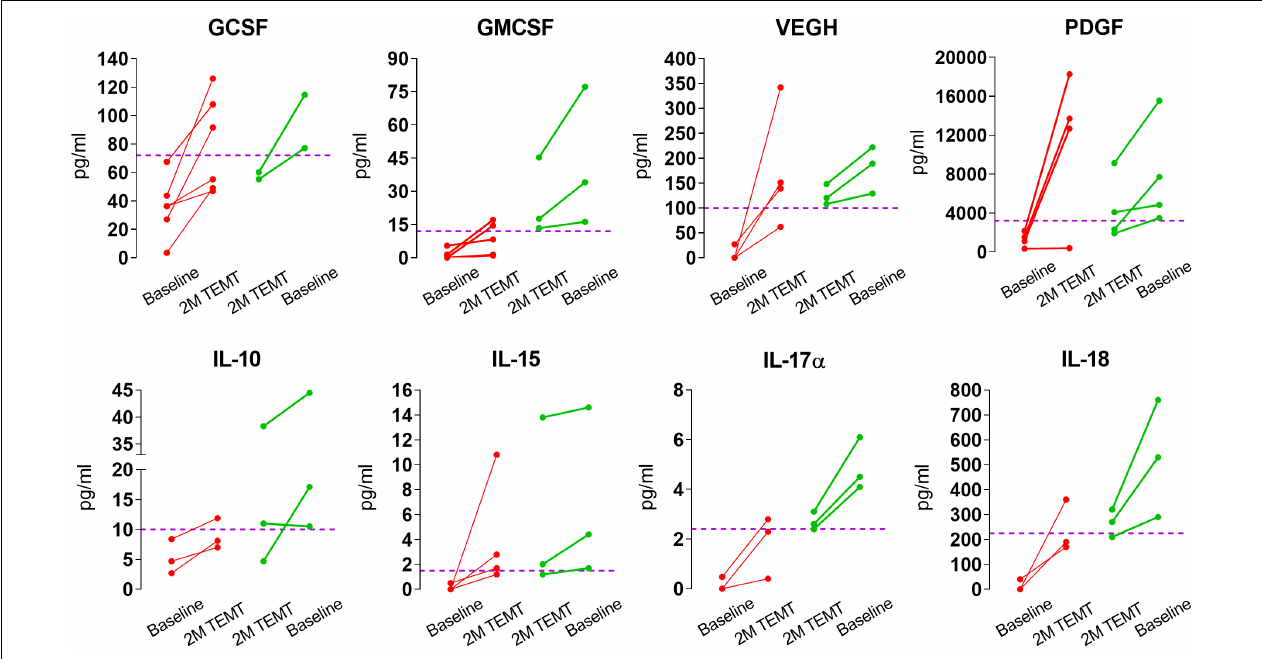
FIGURE 3 | Effects of 2-months of daily TEMT on plasma levels of eight cytokines in AD subjects. As can be seen for all eight cytokines, if baseline plasma levels were low (below the horizontal “convergence” dashed line), TEMT resulted in increased blood levels after 2-months of treatment (red lines). Conversely, if baseline cytokine levels were high, TEMT resulted in decreased blood levels after 60 days of treatment (green lines). Both red and green data points after 2 months of TEMT largely gravitate to at or near the horizontal “convergence” dashed line. These results suggest a clear ability of TEMT to re-balance or attempt to rebalance plasma cytokine levels to